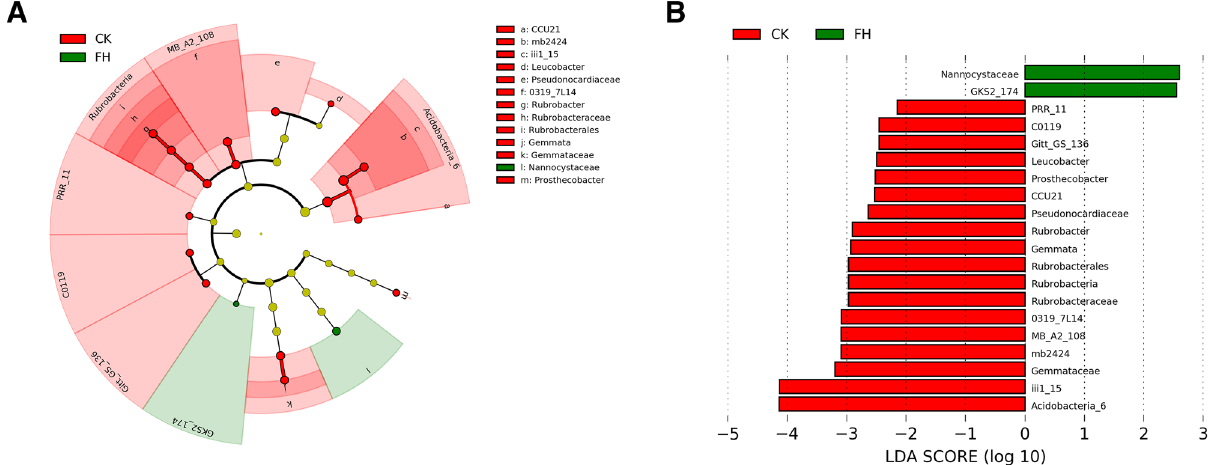
Figure 2. Cladogram ( A ) and linear discriminant analysis (LDA) score ( B ) of LEfSe analysis of the rhizosphere bacterial community between CK (red) and FH (green) treatments. CK non-inoculated, FH inoculated with Bacillus amyloliquefaciens